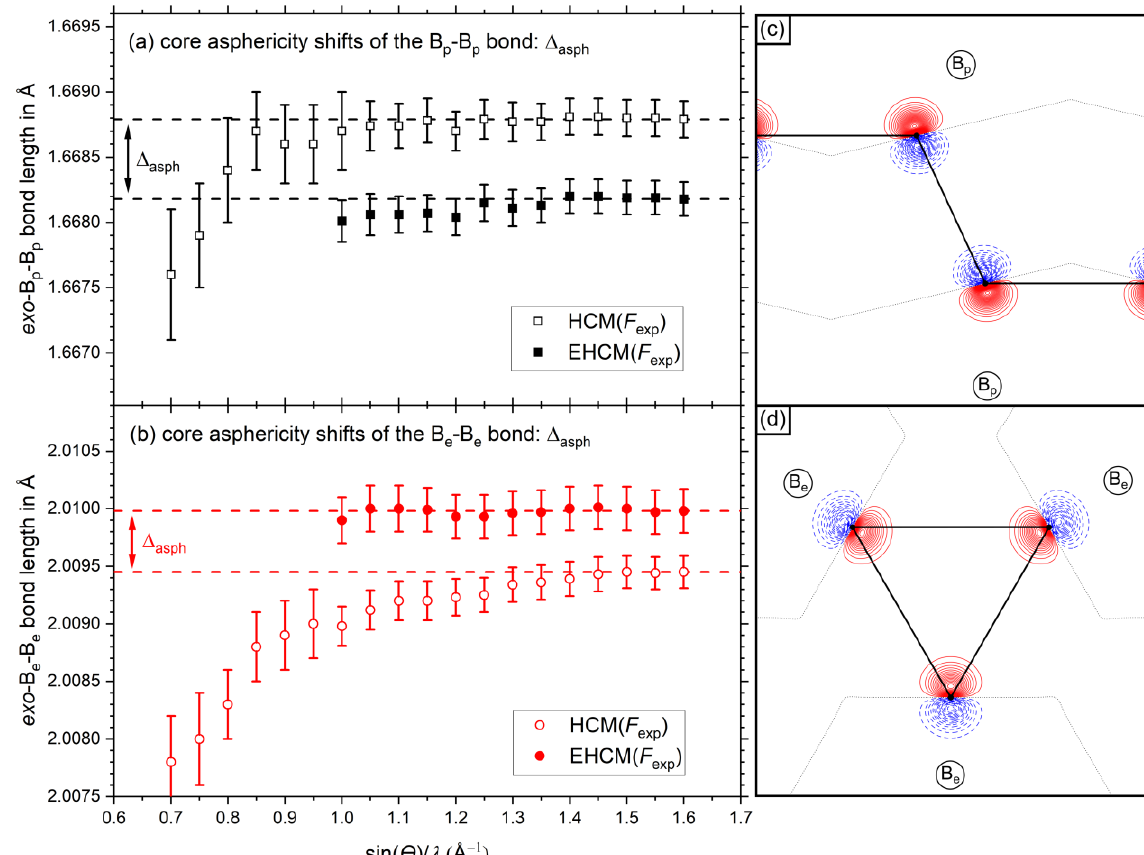
Figure 6. Resolution dependent absolute bond length values of the ( a ) exo -B p -B p -bond and ( b ) exo -B e -B e -bond. Values of the HCM are shown with open symbols, values of the aspherical EHCM( F exp ) are shown with closed symbols. The dashed horizontal lines show the values at maximum resolution as a guide to the eye. The dipolar core polarization contributions according to the EHCM( F sta ) are shown in ( c ) for B p atoms and in ( d ) for B e atoms. Positive (solid red) and negative (dashed blue) contour values are shown in 0.01 eÅ − 3 steps and the zero contour lines are drawn as dotted black